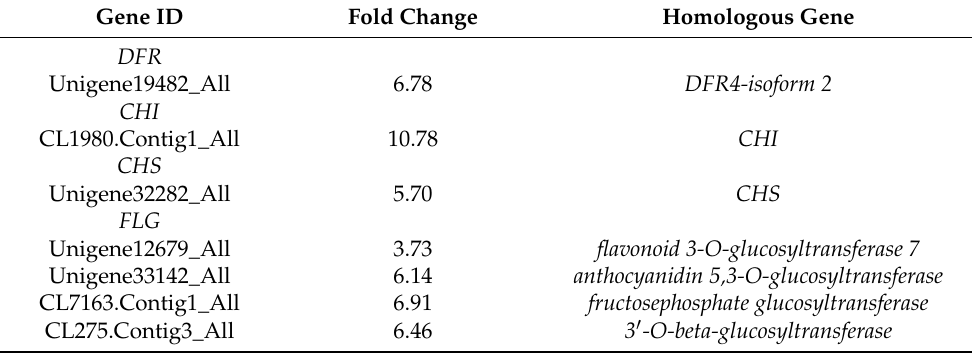
Table 10. The upregulated DEGs related to flavonoids in the roots of A. canescens under 100 mM NaCl, but not under control conditions, for 24